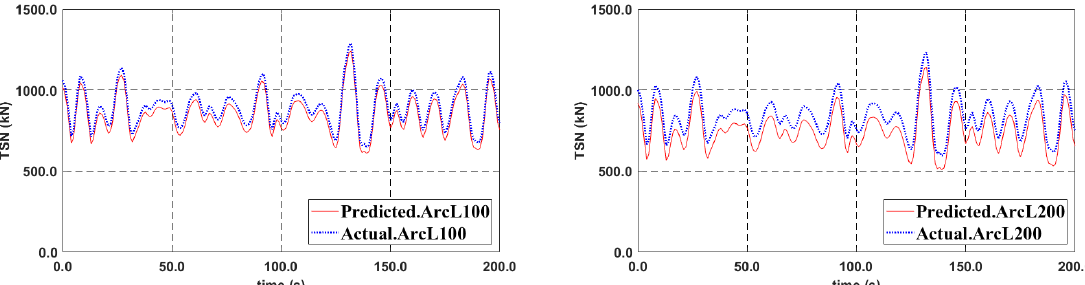
Figure A4. Tension Estimation up to Target Point, 100-yr storm (Down), WD1000, Sensor Interval = 100 m, Umbilical.